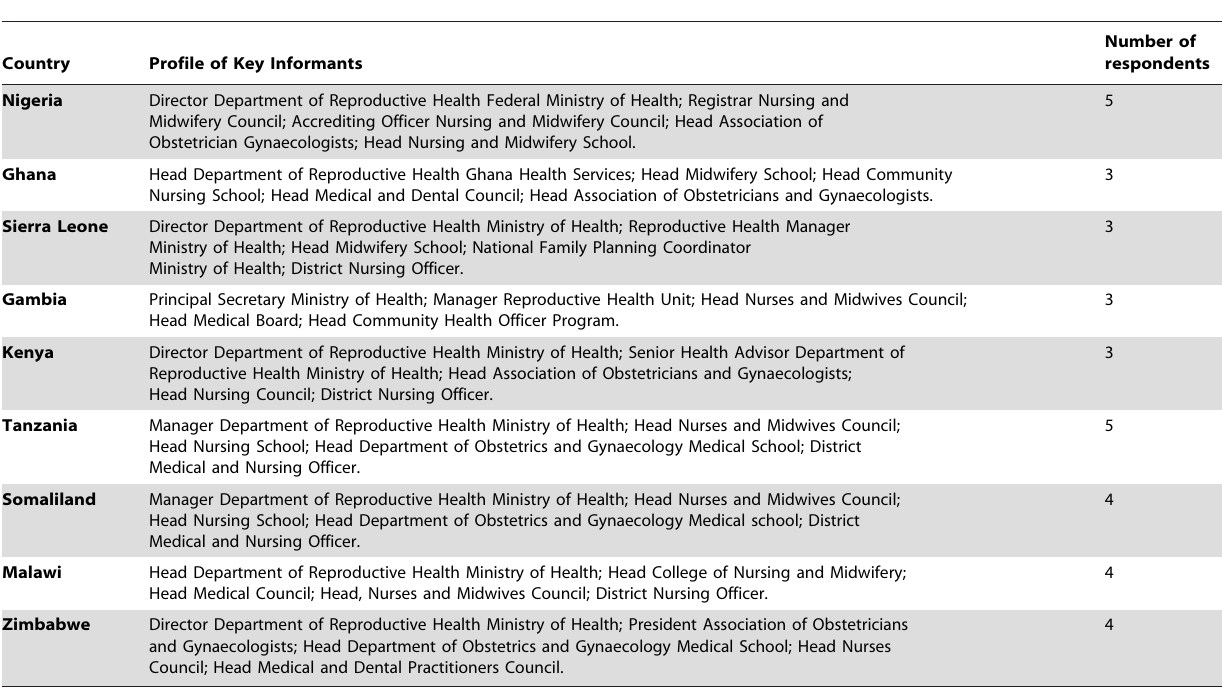
Table 1. Profile of Key Informants and number of respondents by country.